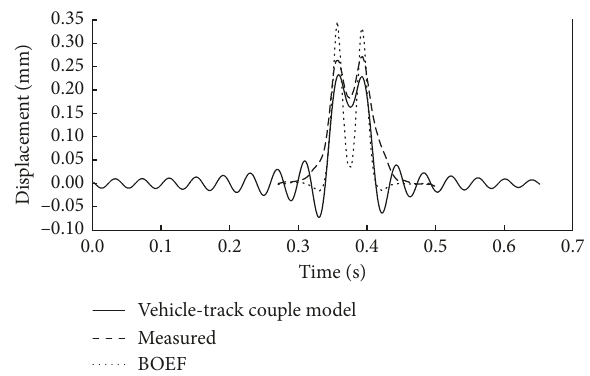
Figure 3: Comparison of measured sleeper displacement with that obtained from using the vehicle-track coupled model and BOEF model for a single bogie.